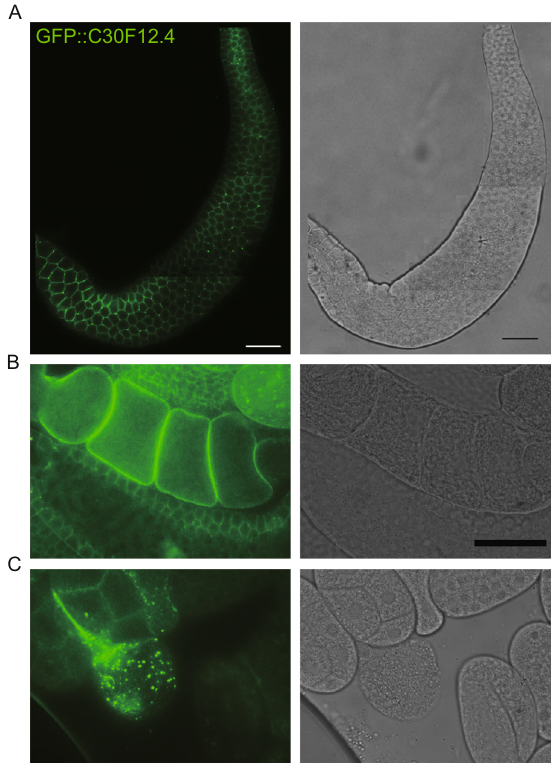
Figure 7. GFP::C30F12.4 was speci fi cally expressed and located in germ cells and early embryos. (A and B) C30F12.4 was mainly located in the cytoplasm around the germ cells and everywhere in oocytes. (C) C30F12.4 displayed a punctate signal in single-cell embryos. Scale bar = 20 μ